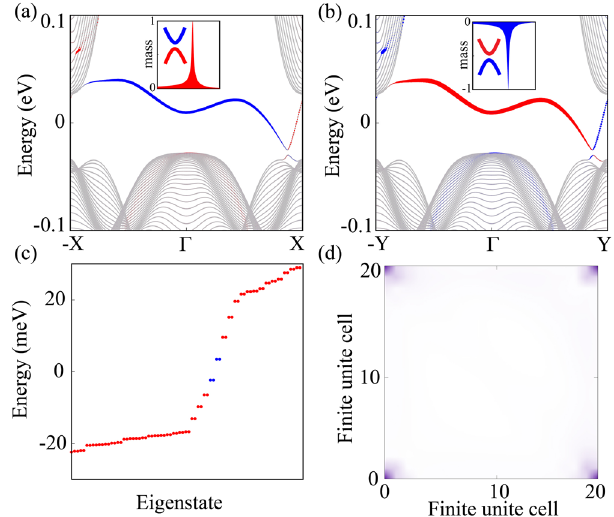
Fig. 4 The edge states and corner states of cb-AFM monolayer FeSe. a , b Spin-polarized edge states along the cuts #2 and #3 boundary, respectively. The weights of positive (negative) σ z eigenvalue is characterized as red (blue). The inset pictures show the calculated mass term σ y near the massive Dirac cone. c Energy spectra of the 20 × 20 fi nite square structure. d Spatial distribution of the two occupied corner